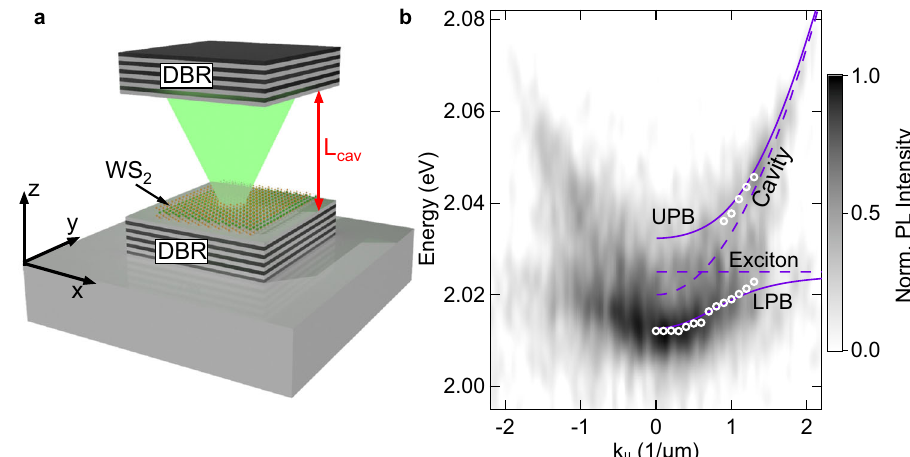
Fig. 1 Open cavity and TMDC monolayer sketch and strong coupling conditions. a Sketch of the open cavity device, composed of two DBRs embedding an air gap. The WS 2 monolayer is placed on top of the bottom DBR. b Momentum-resolved photoluminescence spectrum of the polariton emission for a L µ m, under weak excitation with a green, non-resonant, continuous wave laser. As a result of the peak fi tting of the UPB and LPB modes, see white cav ~2.2 circles, the excitonic and photonic modes [UPB and LPB] are represented with dashed [full] lines for k || > 0. The spectrum is recorded with a pump power of ~5 µ W and 300 s integration